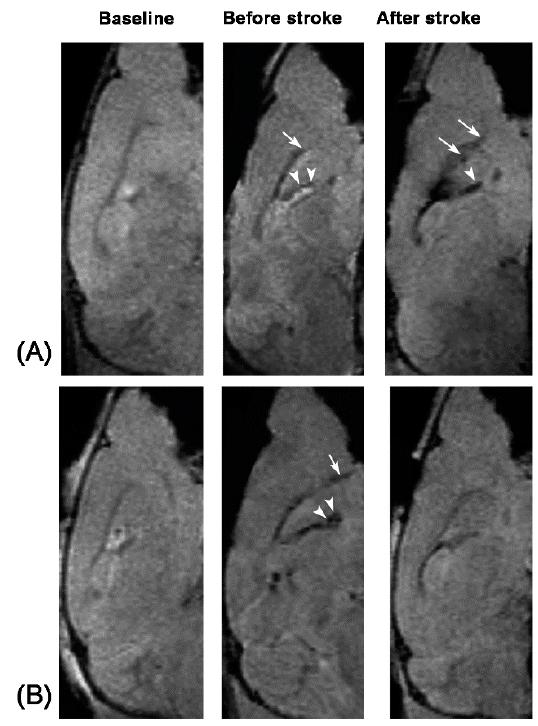
Figure 1 . Serial in vivo MR images of endogenous NSCs from a pure stroke mouse and a stroke mouse treated with Ara-C. Compared with baseline sagittal T2*-weighted images, after intraventricular injection of anti-CD15-SPIONs, linear hypointense signal (arrows), and spotty hypointense signals (arrowheads) appear in the beginning of RMS and SVZ both in the mouse with pure stroke group ( A ) and the mouse with Ara-C treatment ( B ) before induction of stroke. Eight days after stroke, the area of hypointense signal increases in the pure stroke mouse ( A ), while it diminishes in the stroke mouse treated with Ara-C ( B ).